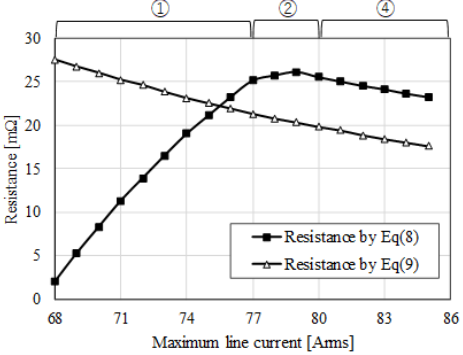
Figure 9. Armature winding resistance r with respect to maximum line current.